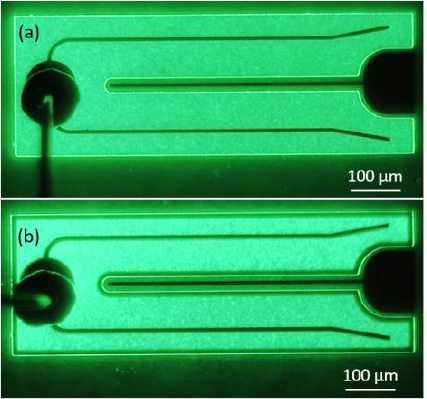
Figure 2. Microscope images of LEDs with the injected current of 3 mA: ( a ) LED I; ( b ) LED III. The current injection suppression into selected regions resulted in the device’s different active areas. To normalize the current density, the active areas of 194,944, 171,358, and 138,797 µ m 2 were used for LED I, II, and III,